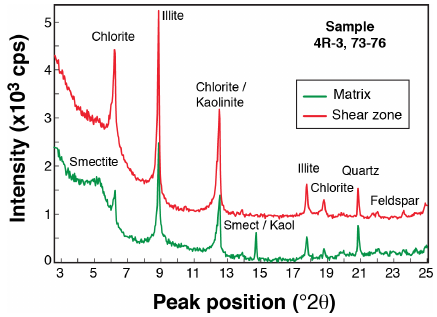
Figure 6. Powder X-ray diffraction spectra of the ethylene-glycol saturated clay-size fraction extracted from a shear zone (in red) and its host matrix (in green) in sample 4R-3,